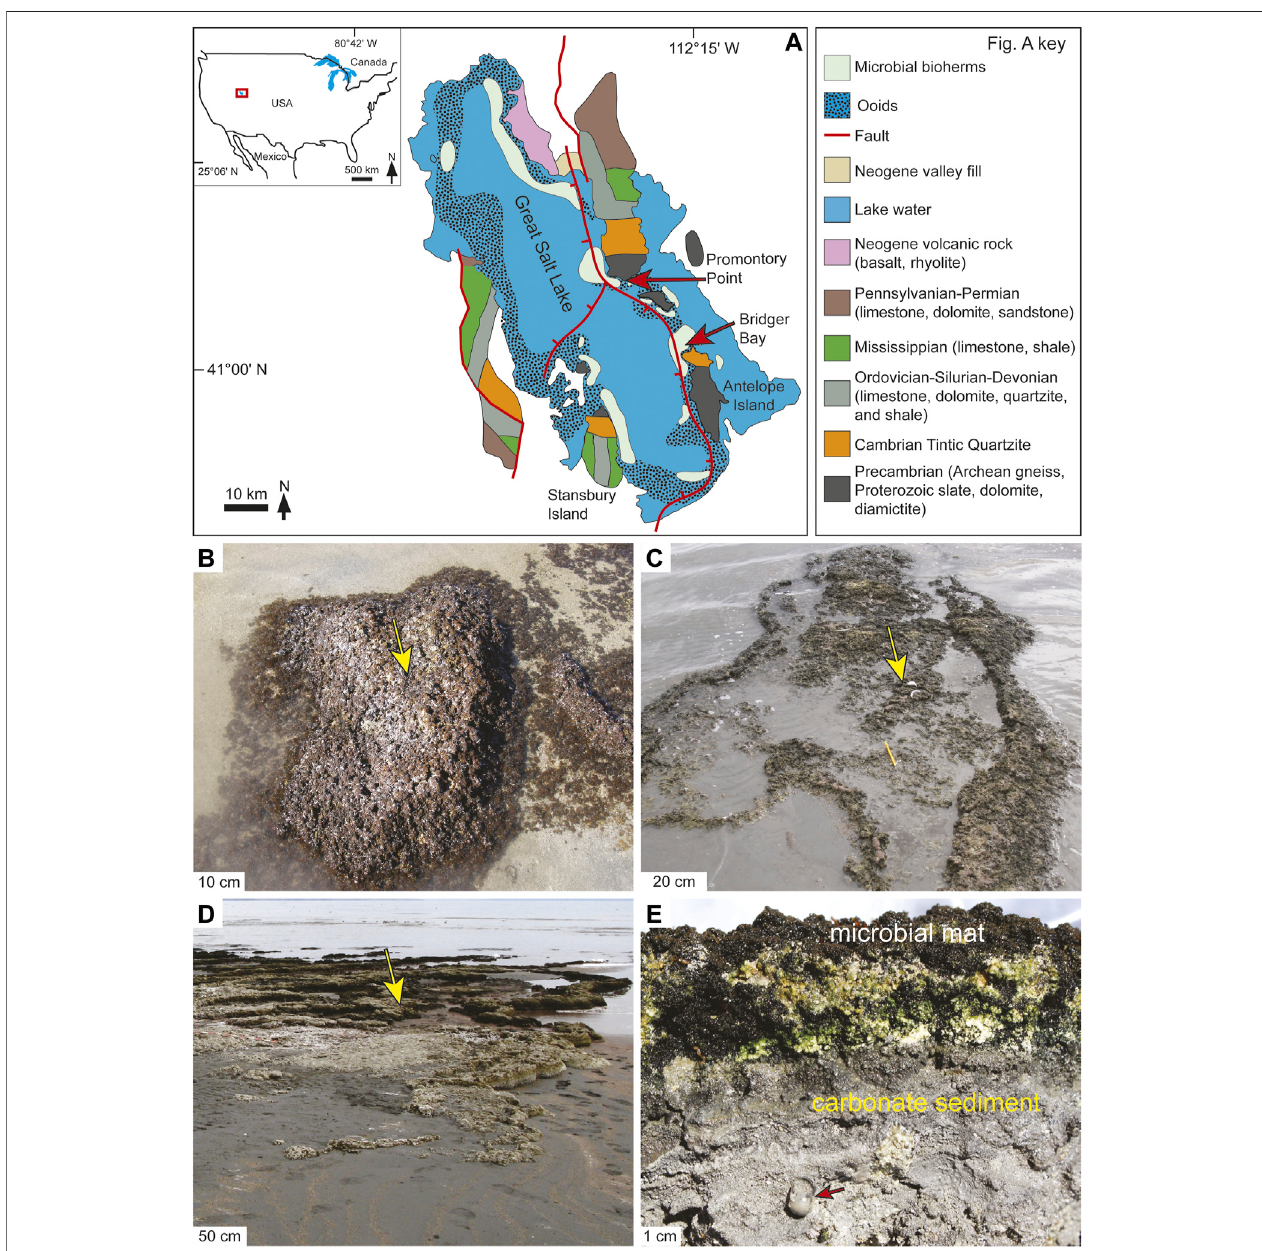
FIGURE 2 | Microbial bioherms in Great Salt Lake, Utah, United States (A) Schematic geological map of the Great Salt Lake (modi fi ed after Della Porta, 2015 and references therein) showing faults extracted from Colman et al. (2002) and distribution of microbial bioherms and ooidal sand from Eardley (1938) and Carozzi (1962). Sampling locations of Promontory Point and Bridger Bay marked by red arrows (B) Isolated roughly circular microbial bioherms (arrowed) at Bridger Bay (C) Elongated microbialbioherms(arrowed)atPromontoryPoint (D) Thebeltformedbyadjacentmicrobialbioherms(arrowed)surroundedbyooidalpeloidalsandatPromontory Point (E) Architectureofthemicrobialbiohermshowinganupperlayerconsisting ofmicrobialmatsandalowerpartconsisting ofprecipitatedcarbonatesediment.Note a gastropod (red arrow) in the carbonate sediment.